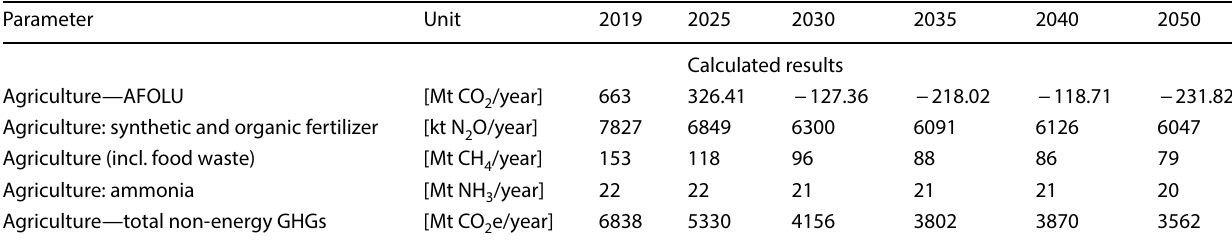
Table 7 Non-energy emissions from the agriculture sector